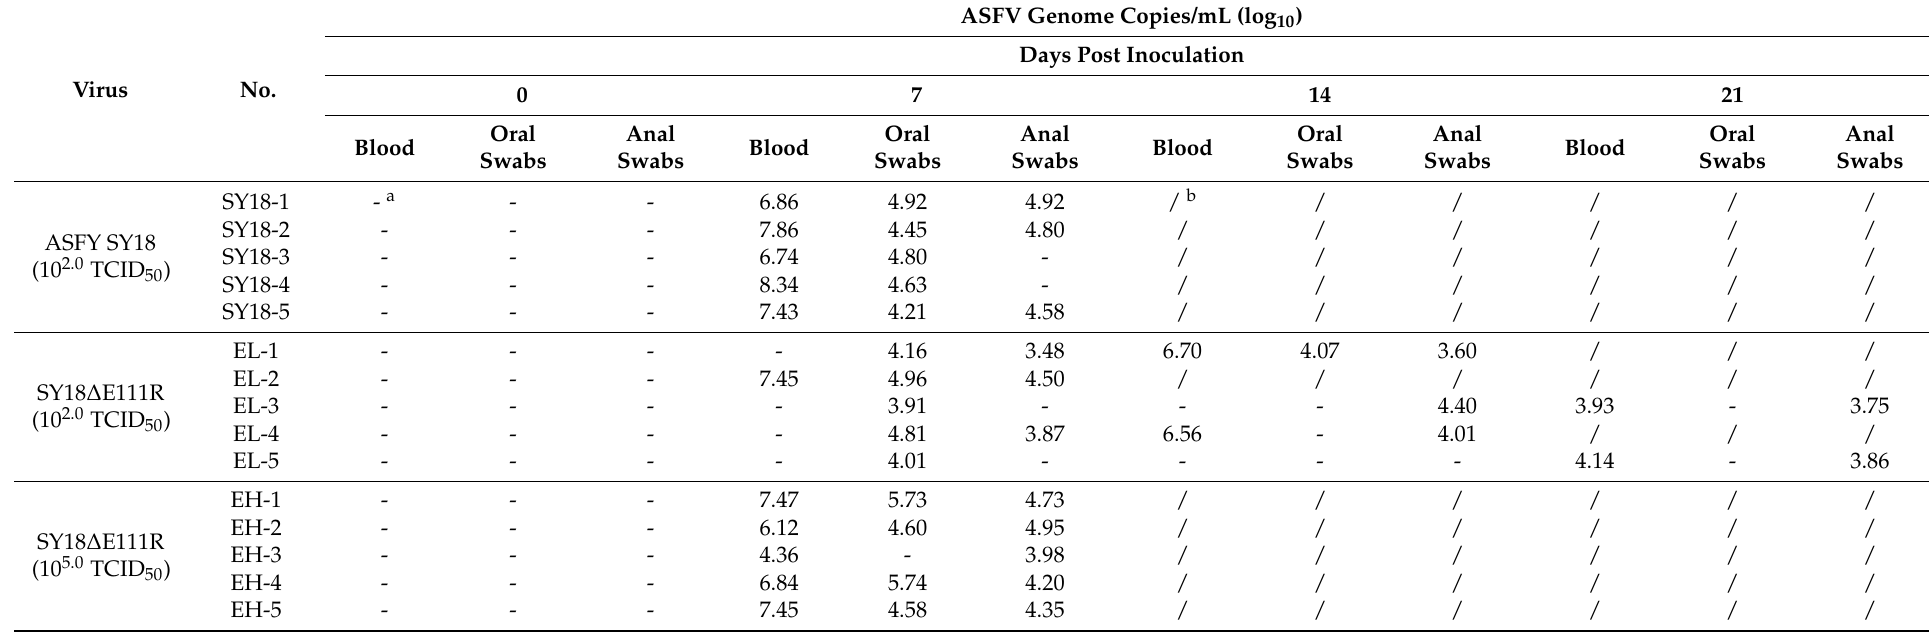
Table 3. Virus genome copies in blood samples; oral and anal swabs from infected pigs.